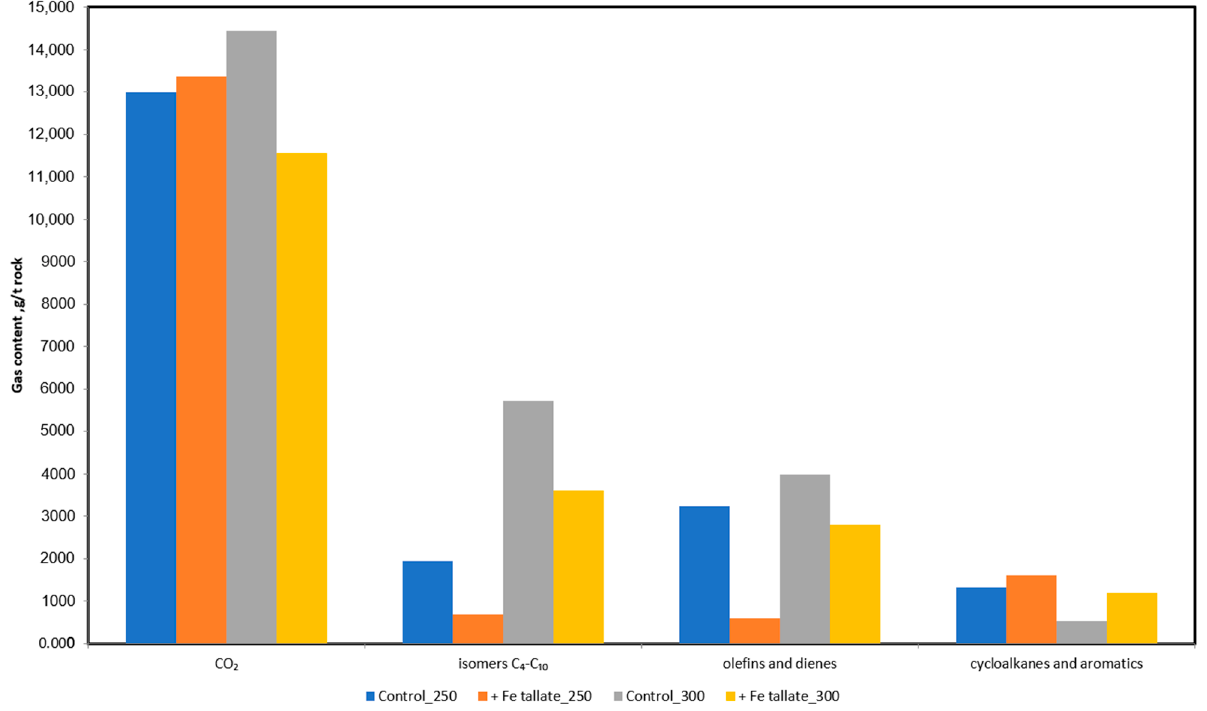
Figure 4. Content and composition of gases (individual gases, cycloalkanes and aromatic HCs, al- cohols and other gases) depending on TST temperature and the presence of iron tallate.